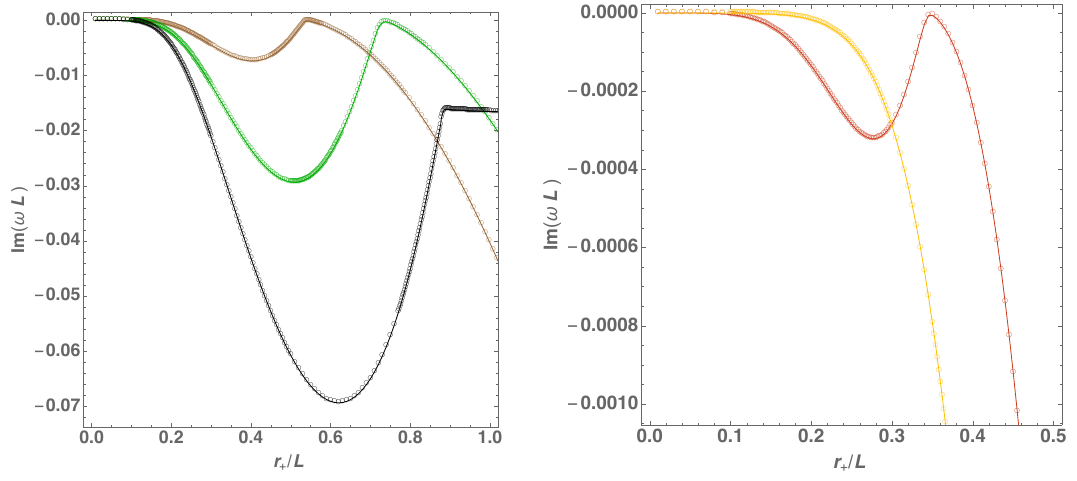
Figure 7 . Imaginary part of the frequency as a function of the horizon radius for chemical potential (cid:22) = 0 : 999 (cid:22) ext for di(cid:11)erent values of the fermion (cid:12)eld charge. In the left panel the charges are (from bottom bump to top) qL = 0 : 7 (black), qL = 0 : 8 (green), qL = 0 : 9 (brown). In the right panel the charges are qL = 1 (red) and qL = 1 : 1 (yellow). Notice the di(cid:11)erent regions scanned by the axes in the two